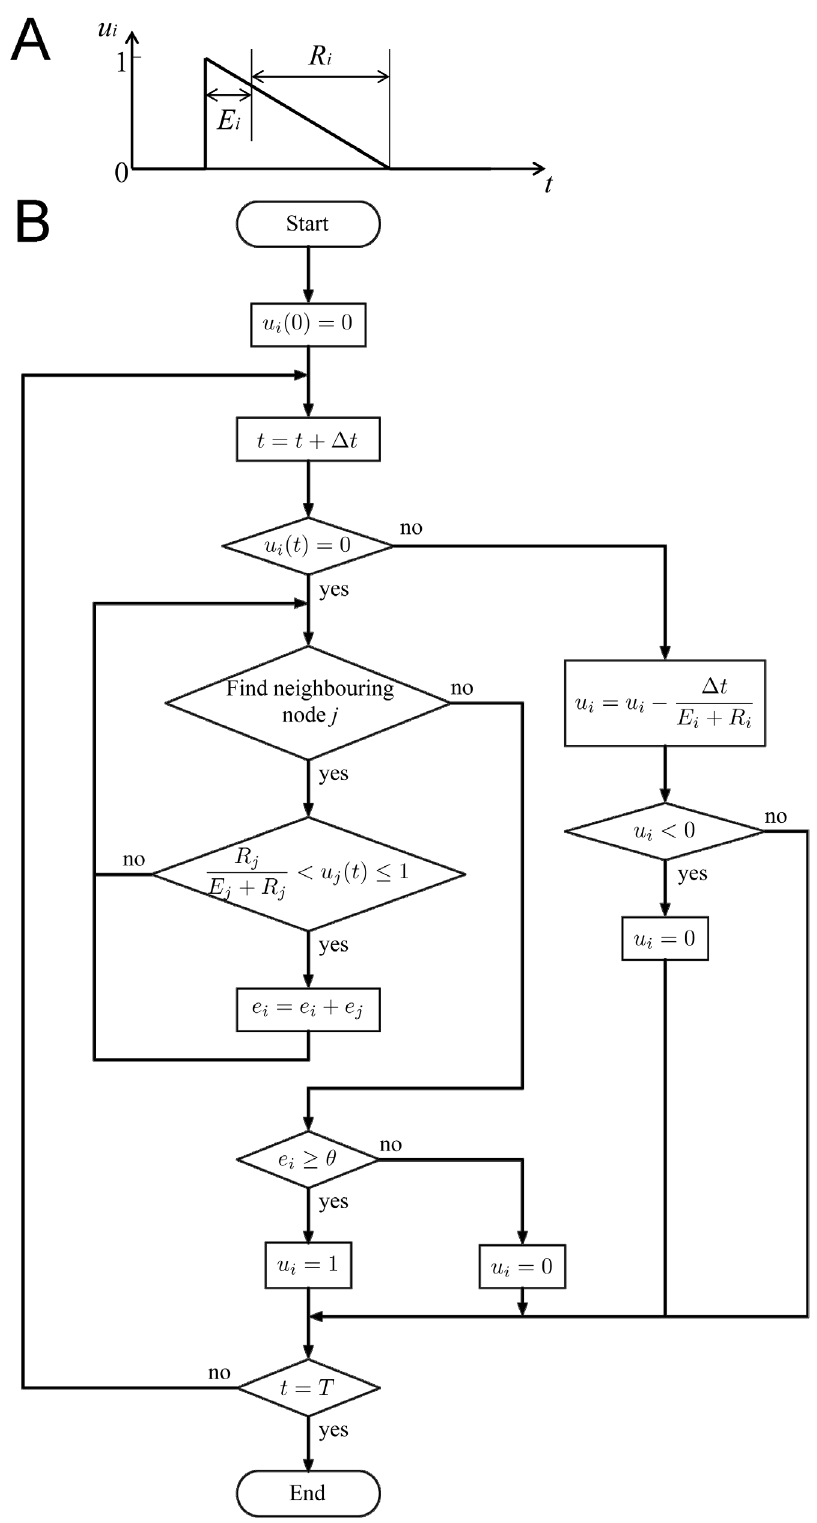
Figure 4. Cellular automaton model. A, time course of state ( u ) of node i in the cellular automaton model. If node i is excited the node state u i is changed from 0 (resting) to 1 (excited). u i then declines back to 0. B, program flow-chart of the cellular automaton model. E i , the excited period; R i , the refractory period. t , time; D t , the time increment; T , the end time of simulation; e i , the excitation counter; h , the threshold.